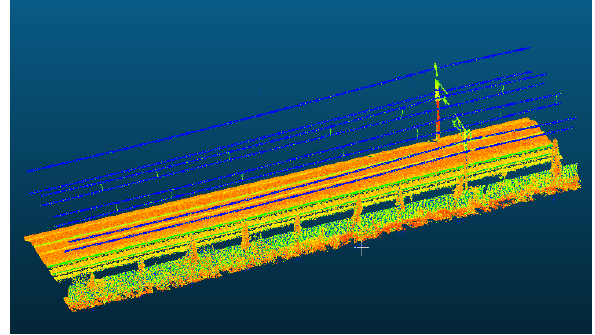
Figure 7. Result of lines detection